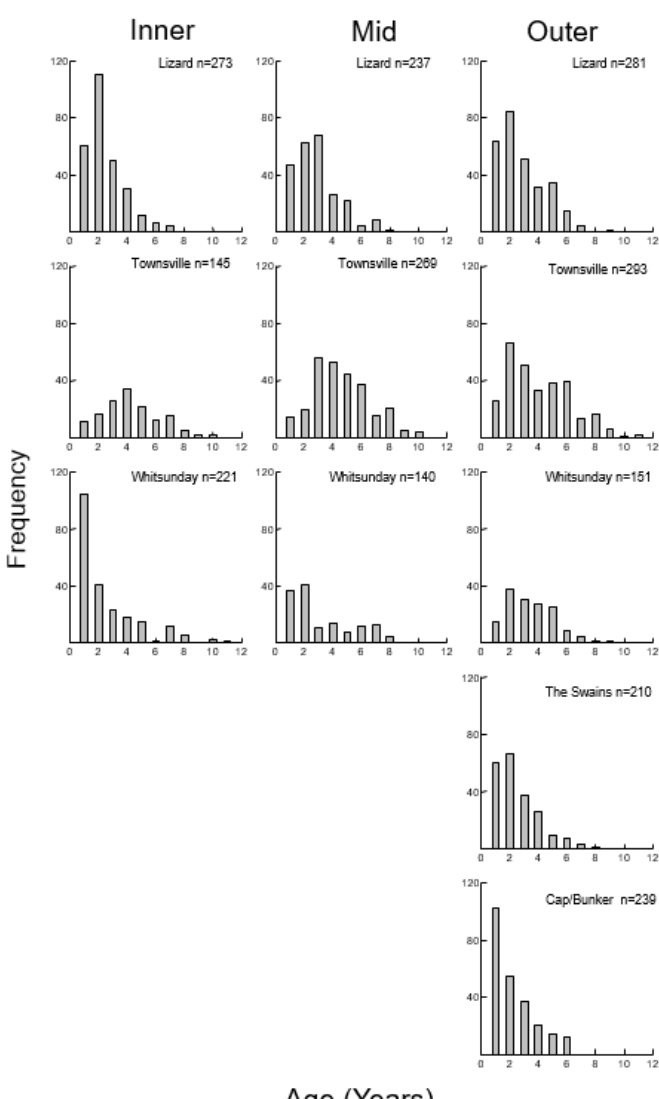
Figure 3. Age–frequency distributions for A. polyacanthus collected from the 13 reefs pooled within distances at each latitude. Table 4. Results of Analysis 2, a nested ANOVA, testing for differences among five latitudes with two reefs nested per latitudes ( n = 7); dependent variables were standard length top 10% and age top 10%. Variance components describe the variation contributed to each factor as a percentage. The denominator MS for latitude is Reef (Lat) and that of Reef (Lat) is the residual; * p < 0.05; *** p < 0.001.